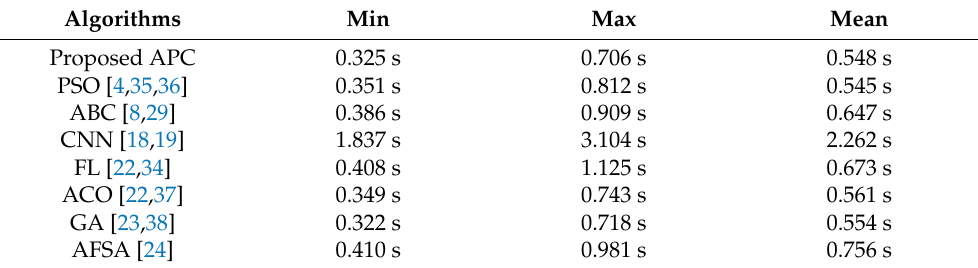
Table 5. Data statistics related to computing time (200 sensor nodes, communication range r = 20 m, 20% anchor nodes, population size m = 20).